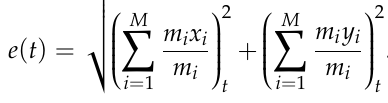
Figure 11. Initial schematic of a rotation–translation nanoconvertor with a hydrogenated deformable part (HDP) on the rotor from carbon nanotube (CNT) (6, 6). ω is the input rotational frequency exerted on the left edge of the L-rotor. d , the output of the system, is the axial distance between the right edges of the R-rotor and the R-stator2 from CNT (11, 11). The right edge of the R-rotor has a translational velocity of v during the deformation of the HDP. On the internal sides of the up and down layers of the HDP, the N H lines of neighboring carbon atoms were hydrogenated. N H was no more than six. The rotors were made from a (6, 6) CNT, and stators from a (11, 11) CNT. The dimension unit is Å. “//z” means parallel to z-axis. Table 1. Initial parameters of the HDPs in the nanoconvertor in Figure 11.